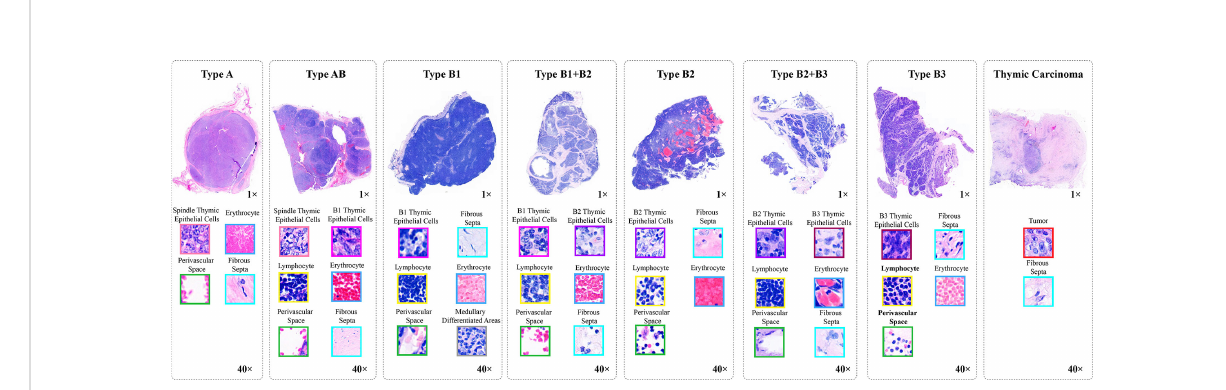
FIGURE 2 The pathological information against the thymoma types. Concretely, there are 10 pathological information classes (spindle thymic epithelial cells, B1 thymic epithelial cells, B2 thymic epithelial cells, B3 thymic epithelial cells, fi brous septa, erythrocyte, lymphocyte, perivascular space, medullary differentiated areas, and tumor) and eight types (A, AB, B1, B1+B2, B2, B2+B3, B3 and TC).